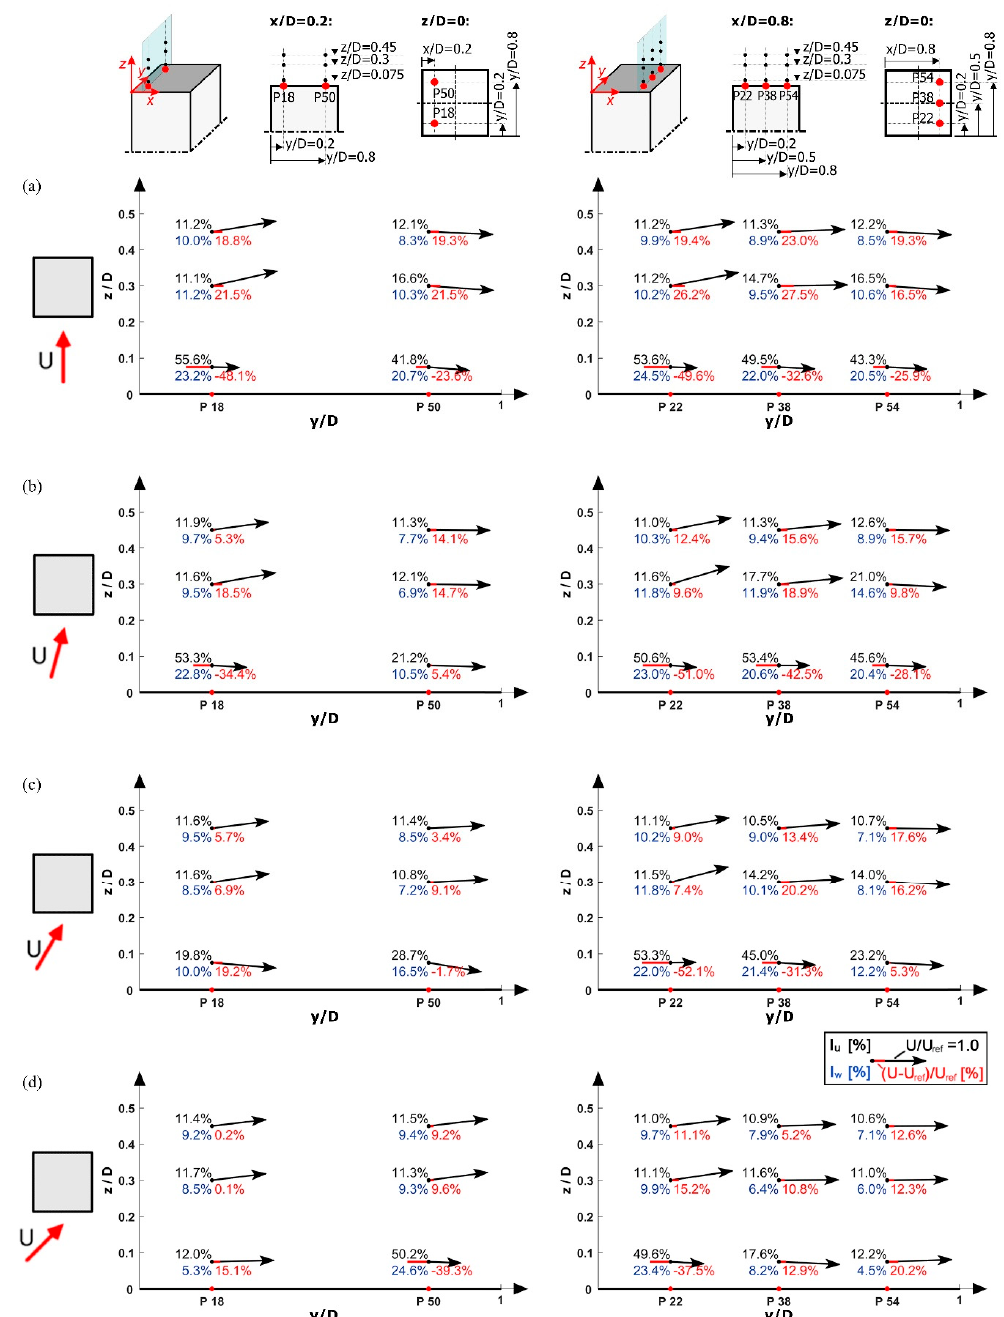
Figure 5. Velocity vectors profiles, based on the stream-wise and vertical velocity components, showing the stream-wise turbulence intensity I U , the vertical turbulence intensity I W and the percentage increase in the stream-wise wind speed. Each numerical value reported at every measurement point in the figure shows the following statistics: I U [%] above on the left; I W [%] below on the left; (U-U ref )/U ref [%] below on the right. Profiles over the flat-roof high-rise building are measured above points 18 and 50 (belonging to the marked line x/D = 0.2, left) and above the points 22, 38 and 54 (belonging to the marked line x/D = 0.8, right) for wind directions: ( a ) 0°, ( b ) 15°, ( c ) 30° and ( d ) 45°. The arrows indicate the velocity magnitude normalised with the reference velocity ( U ref ), as referred to the unity vector represented in the legend.